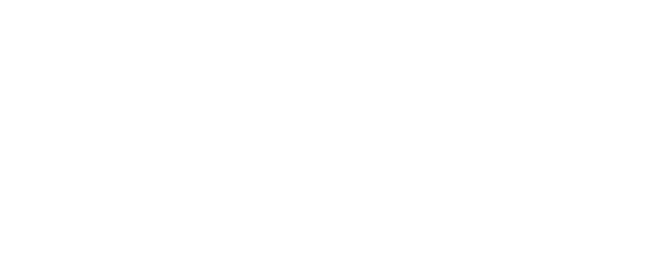
Table 4. DC water pump datasheet.